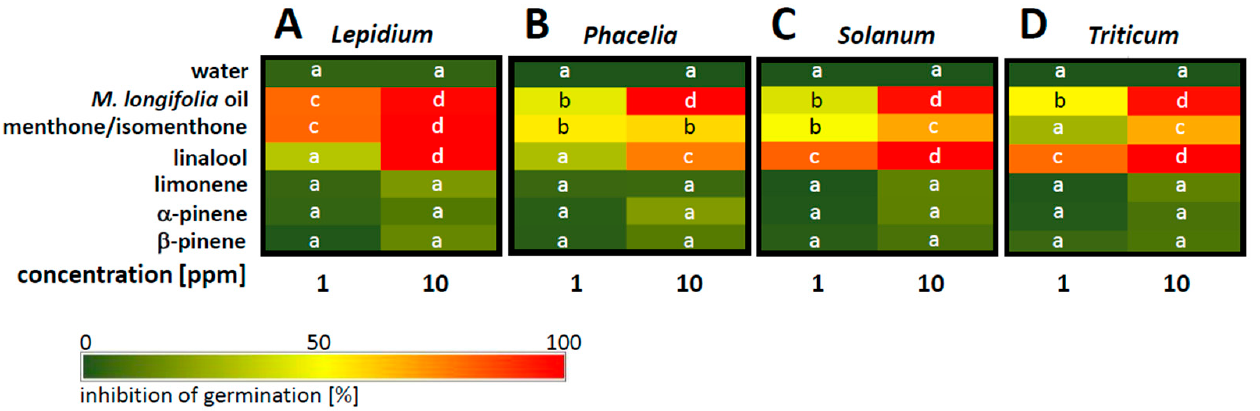
Figure 3. Species spectrum of sensitivity to essential oil from M. longifolia and of compounds found therein administered through the gas phase. Inhibition of germination rate; mean values from three independent replications with 100 individuals scored for each experiment. Responses are shown for Lepidium sativum ( A ), Phacelia tanacetifolia ( B ), Solanum Lycopersicon ( C ), and Triticum aestivum ( D ). Letters indicate groups that are different with respect to the Least Significant Difference (LSD) test for a significance threshold of p <